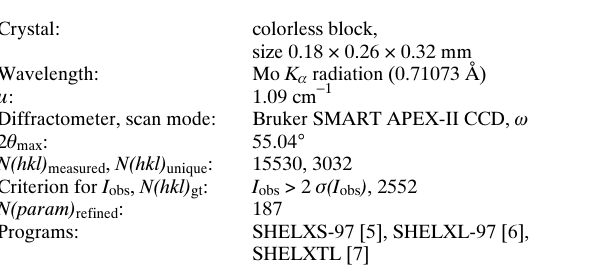
Table 1. Data collection and